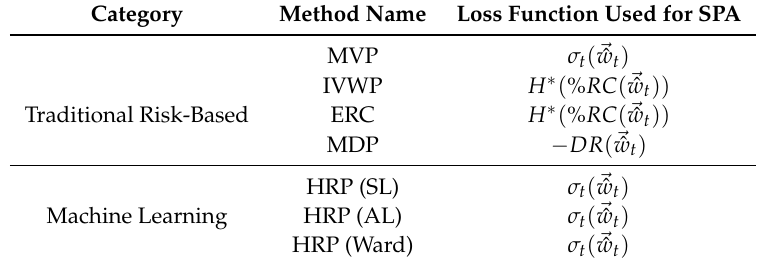
Table 2. The portfolio allocation method and corresponding loss function to determine benchmark covariance forecast